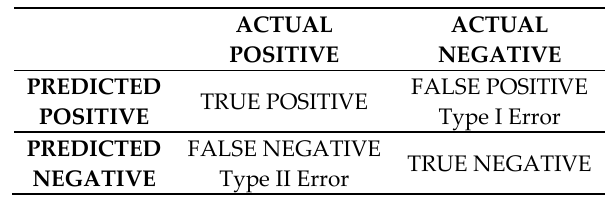
Figure A2. Example learning curve for a random forests model classifying vertebrates and arthropods. Accuracy is the proportion of vertebrate and arthropod out-of-box resolution volumes correctly classified. The 15 training/test sample sizes ranged from 10 to 163,840 in power increments of 10·2 x where x varied from 0 to 14. The model was executed 20 times for each sample size increment enabling estimates of the x ̄ ± SD shown. The vertical dashed line represents per class sample size (47,620) used in nearly all analyses.